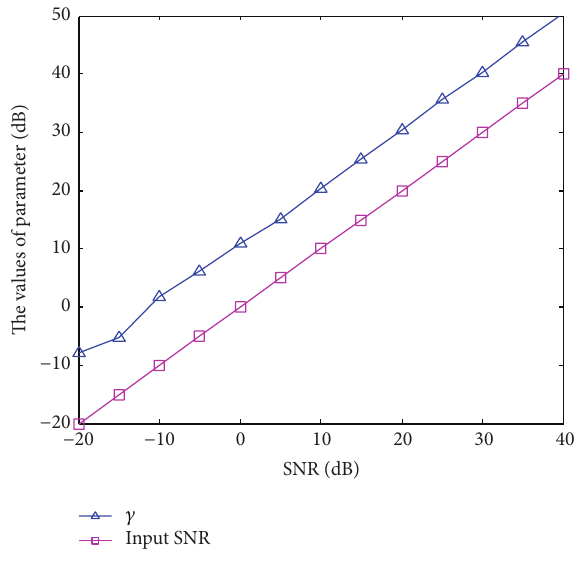
Figure 1: Values of 𝛾 versus the